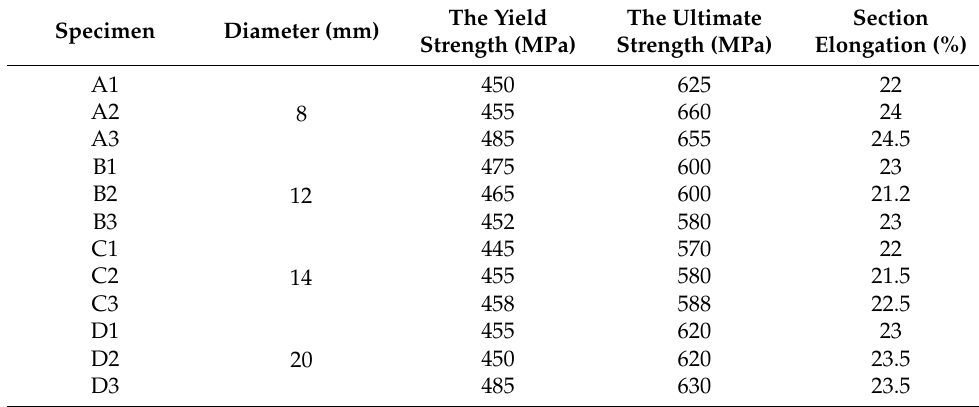
Table 1. The tensile properties of reinforcements.